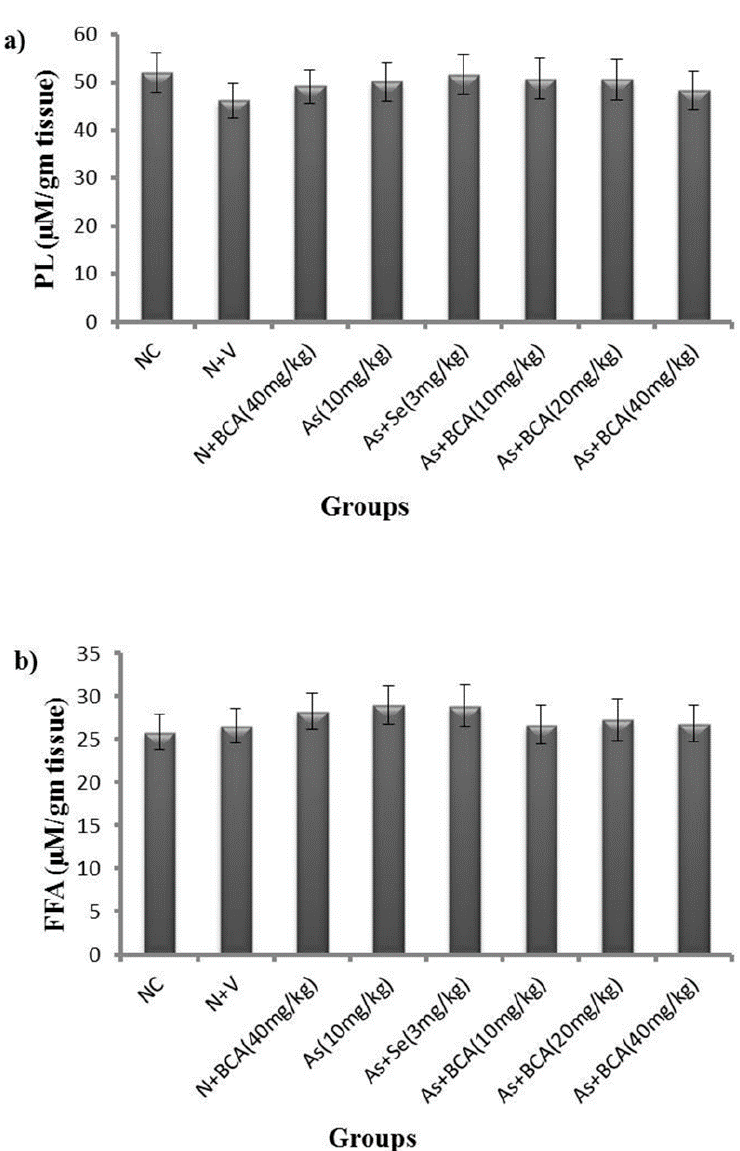
Figure 3. Differences between the levels of phospholipids ( a ) and free fatty acids ( b ) in livers of normal control and experimental rats. All values are expressed as means ± SD ( n = 6). NC: Normal control; N: Normal; V: Vehicle; BCA: Biochanin A; As: Arsenic; Se: Selenium.